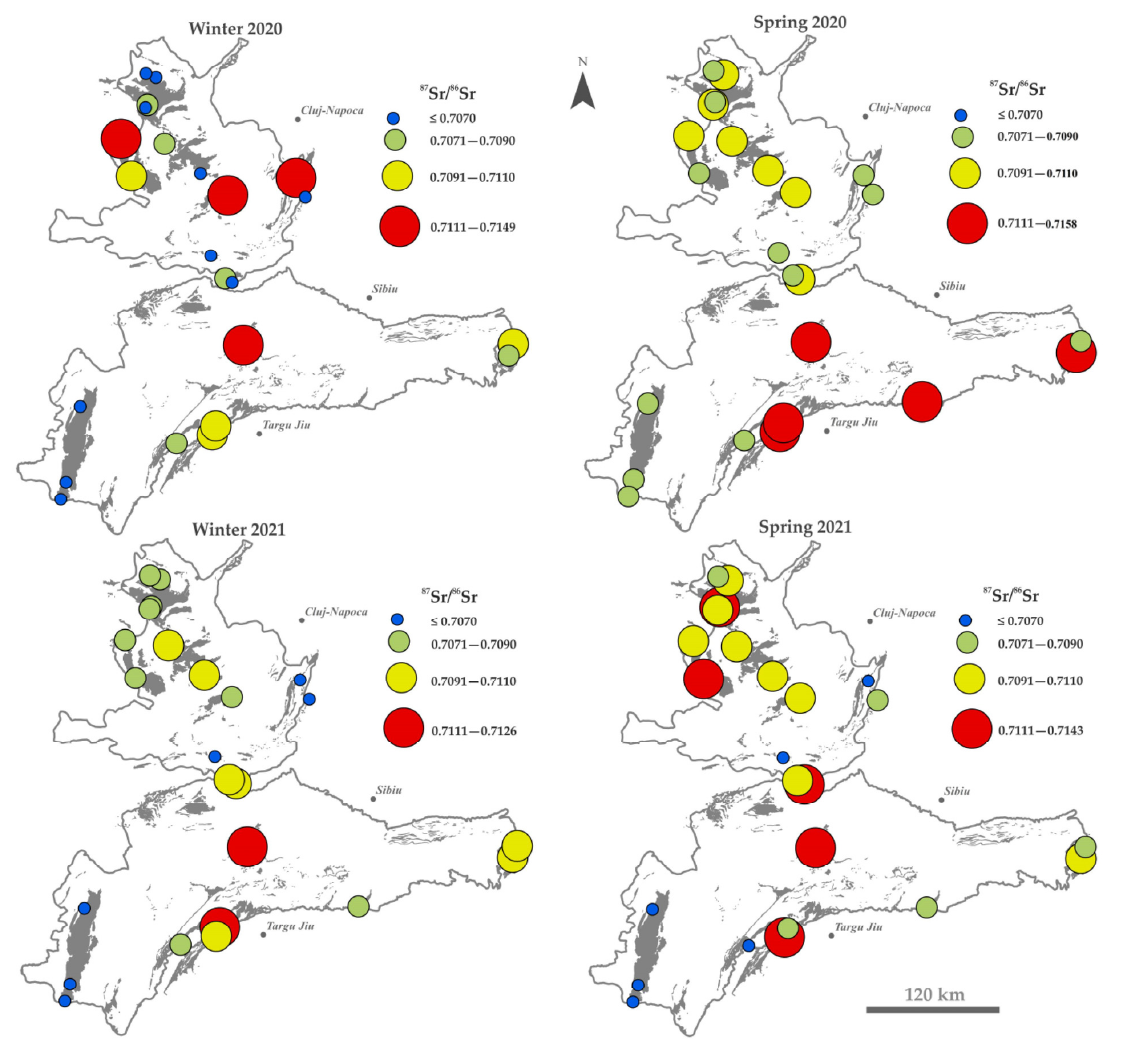
Figure 7. 87 Sr/ 86 Sr ratio in the groundwaters from Southern Carpathians (SCP) and Apuseni Moun- tains (APS) karst areas.